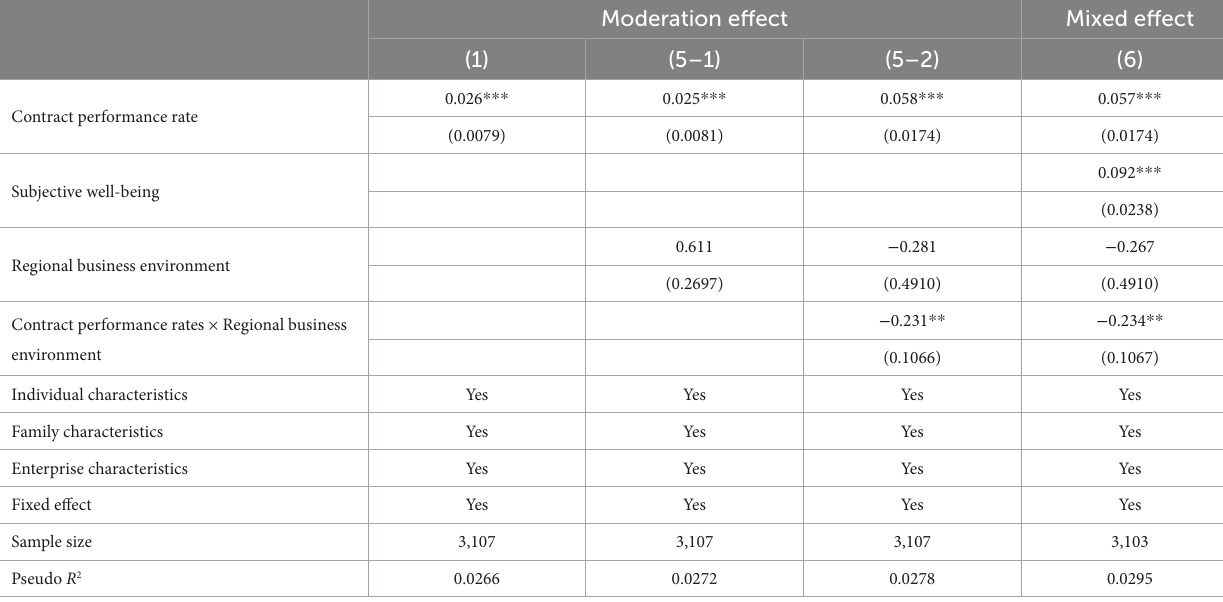
TABLE 6 Oprobit regression results of the moderating and mixed